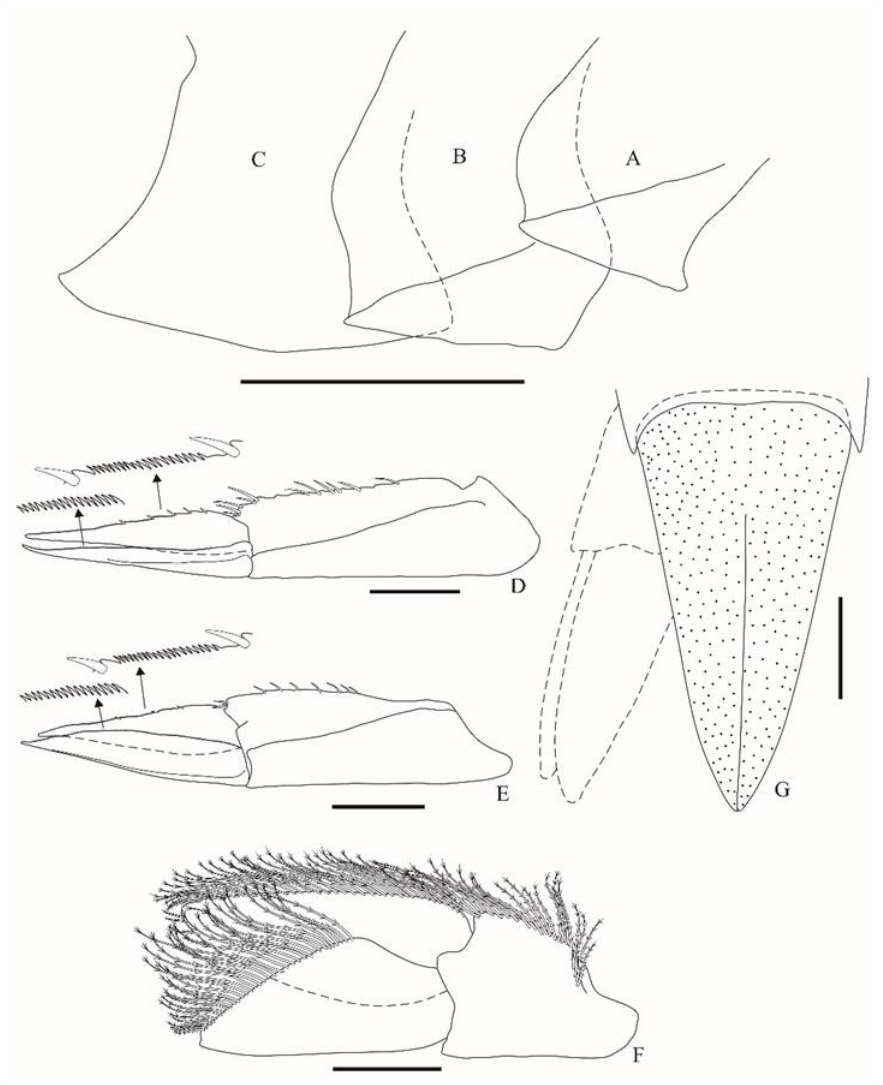
Figure 6. Cyphocaris boecki sp. nov., female holotype, 33.3 mm (MOUFPE 20068). ( A – C ) Epimeral plates 1 – 3, respectively; ( D – F ) uropods 1 – 3, respectively; ( G ) telson. Scale bars: 3 mm for ( A – C ); 1 mm for ( D – G ).